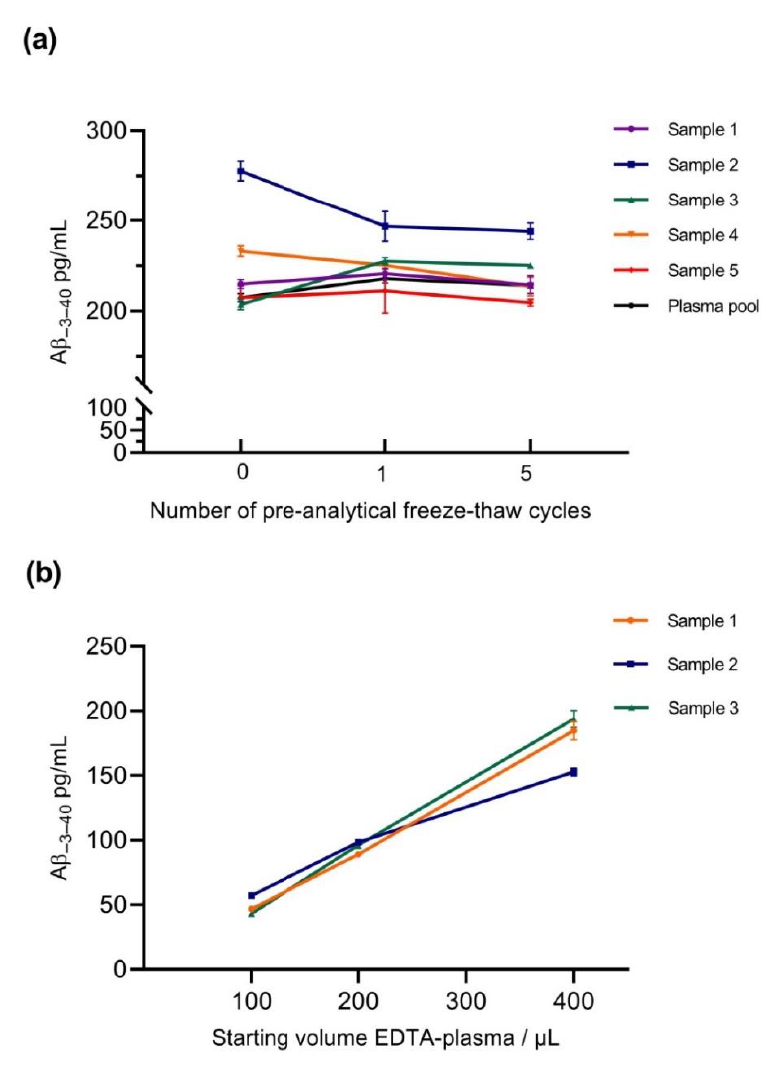
Figure 6. Impact of pre-analytical sample handling procedures on the measurement of A β − 3–40 . ( a ) Impact of pre-analytical freezing and thawing of diluted IP eluates. IP eluates obtained by 1E8 magnetic bead IP from aliquots of five individual and one pooled plasma sample were diluted with Diluent-35 and measured in the A β − 3–40 assay freshly or after one or five freeze–thaw cycles. Mean calculated concentrations from two technical replicates on the assay plate and SDs are shown. ( b ) Impact of changing the starting volume and diluting the blood plasma used for IP. IPs from three di ff erent original blood plasma samples were done starting from 400 µ L of EDTA plasma, from 200 µ L of EDTA plasma mixed with 200 µ L of Diluent-35, and from 100 µ L of EDTA-Plasma plus 300 µ L of Diluent-35. The resulting IP eluates were diluted 4.8-fold with Diluent-35 and stored at − 80 ◦ C until the analysis. Means ± SDs from triplicate reads are shown.